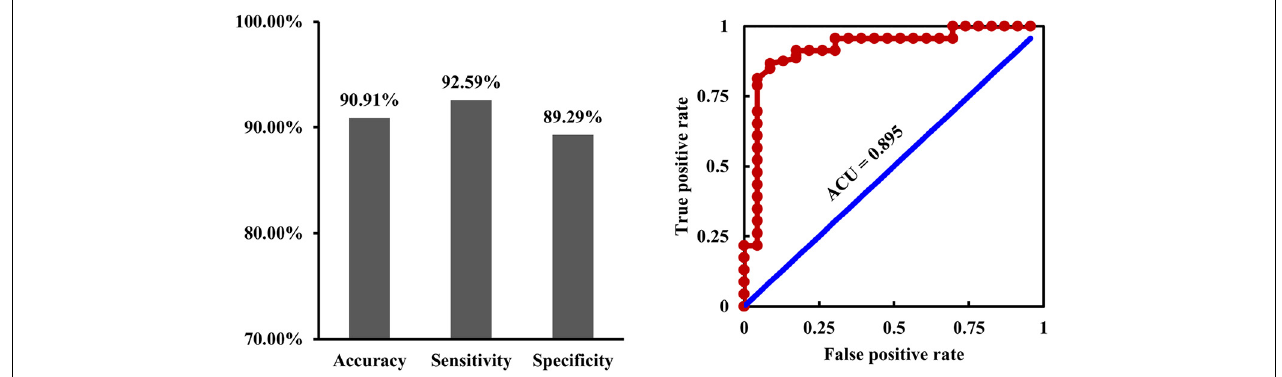
FIGURE 6 | Fusion of connectivity measures for classification. By fusion of the changed resting-state, functional connectivities, causal effective connectivities, and dynamic functional connectivities as features, support vector classification could effectively differentiate depression from healthy controls with an accuracy of 90.91%, a sensitivity of 92.59%, a specificity of 89.29%, and an ACU of